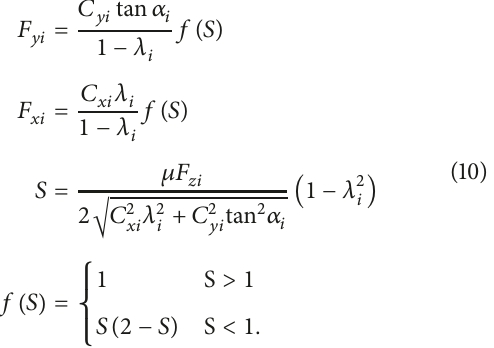
Figure 6: Steering wheel angle with 105 km/h double lane change (DLC).